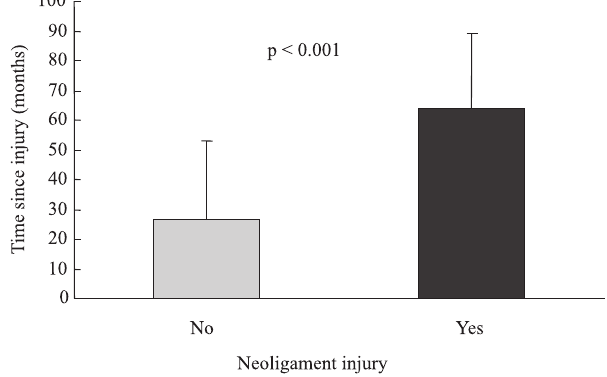
Figure 2 – Graph showing the time since injury for groups with and without neoligament